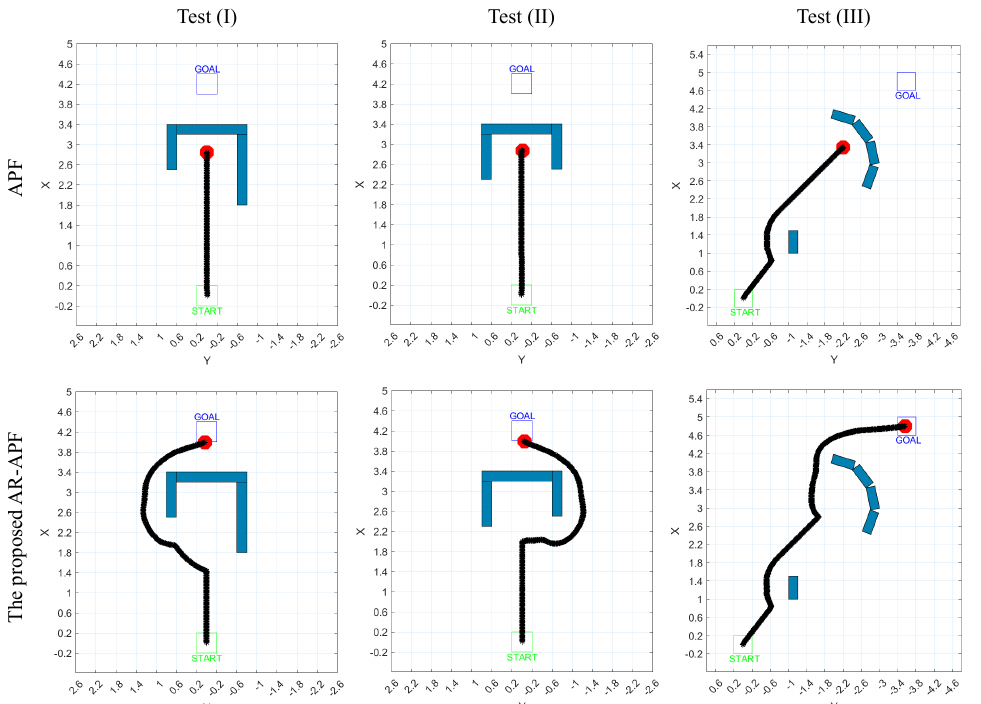
Figure 15. Comparison of the mobile robot’s trajectories with implemented AFP and the proposed AR-APF for Tests